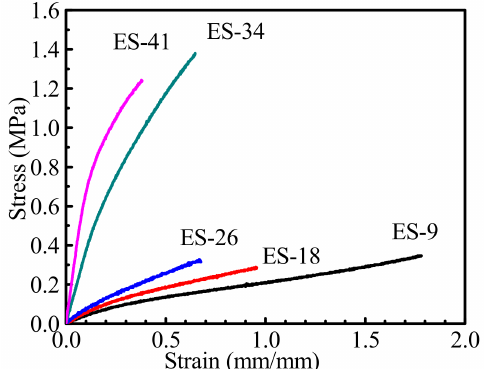
Figure 6. Tensile curves of modified silicone